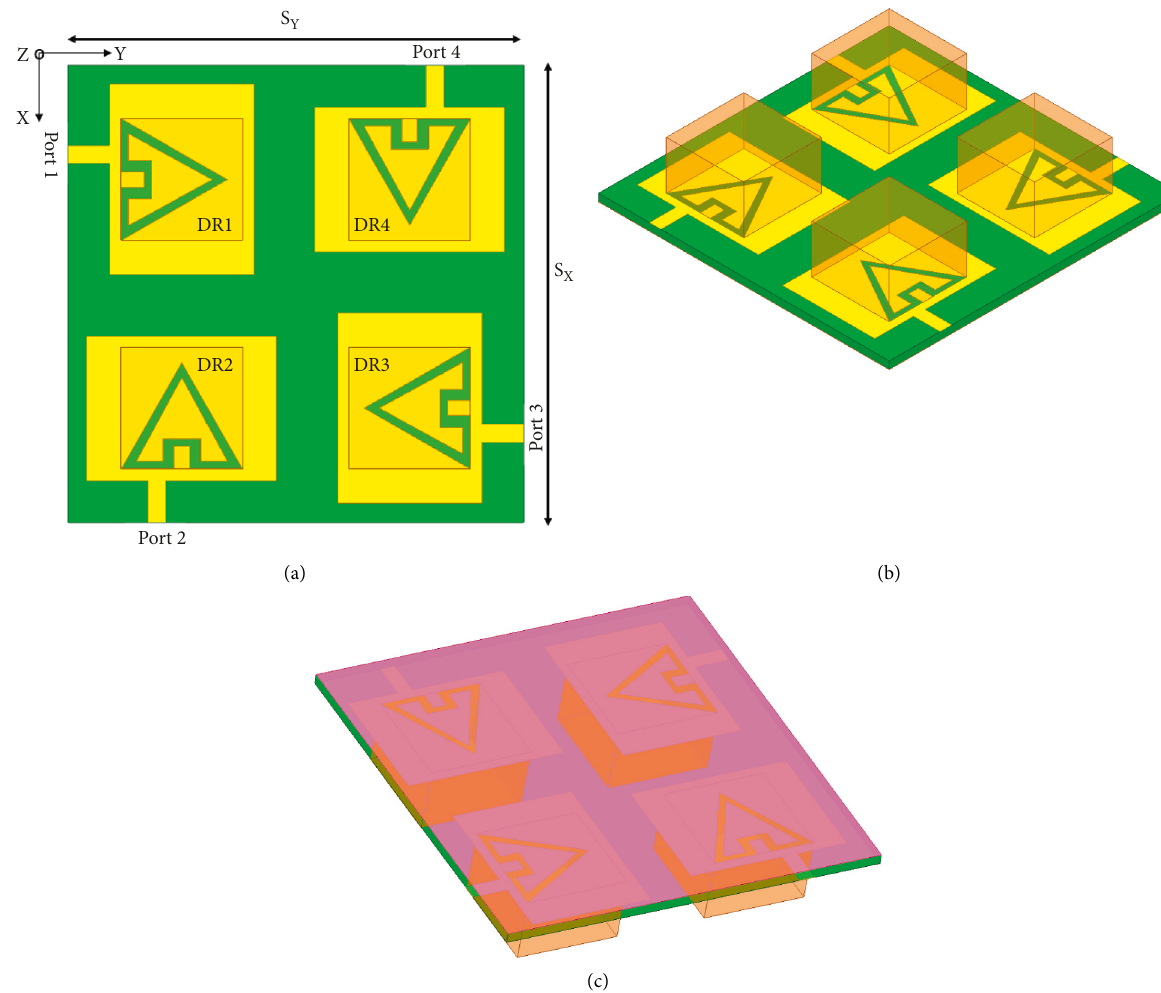
Figure 5: Proposed MIMO antenna: (a) top view, (b) top perspective view, and (c) bottom perspective view (full ground